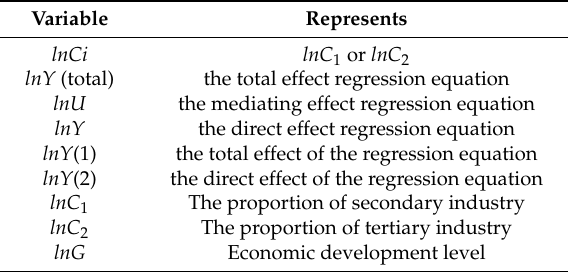
Table 3. The explanation of